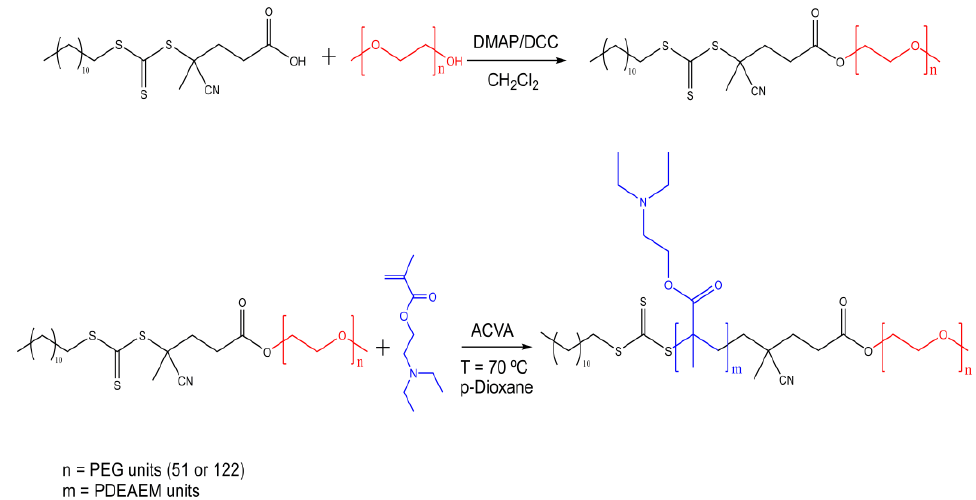
Figure 1. Synthetic scheme for the preparation of PEG- b -PDEAEM block copolymers by RAFT polymerization.